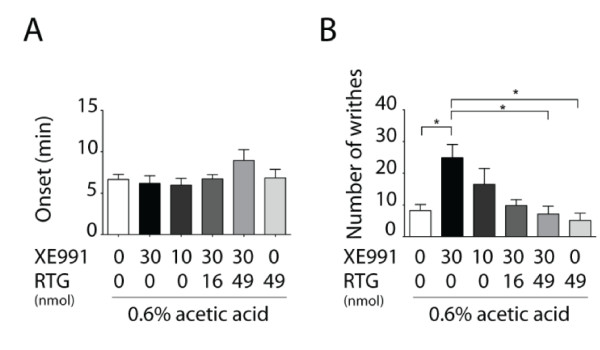
Effect of intracerebroventricular (i.c.v.) administration of KCNQ channel modulators on visceral pain induced by acetic acid in wild type mice. The onset (A) and the total number of writhes (B) after induction of visceral pain by 0.6% acetic acid (i.p.) were determined over a period of 15 min with XE991, retigabine (RTG) or vehicle administered by i.c.v. injection. XE991 (30 nmol) significantly increased the number of writhes, and RTG (49 nmol) reversed its effect. Data are expressed as mean ± s.e.m (n = 7-13, *p < 0.05).